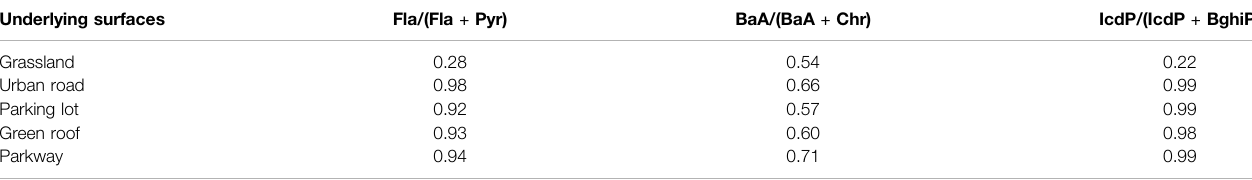
TABLE 6 | Feature ratios of PAHs on the different underlying